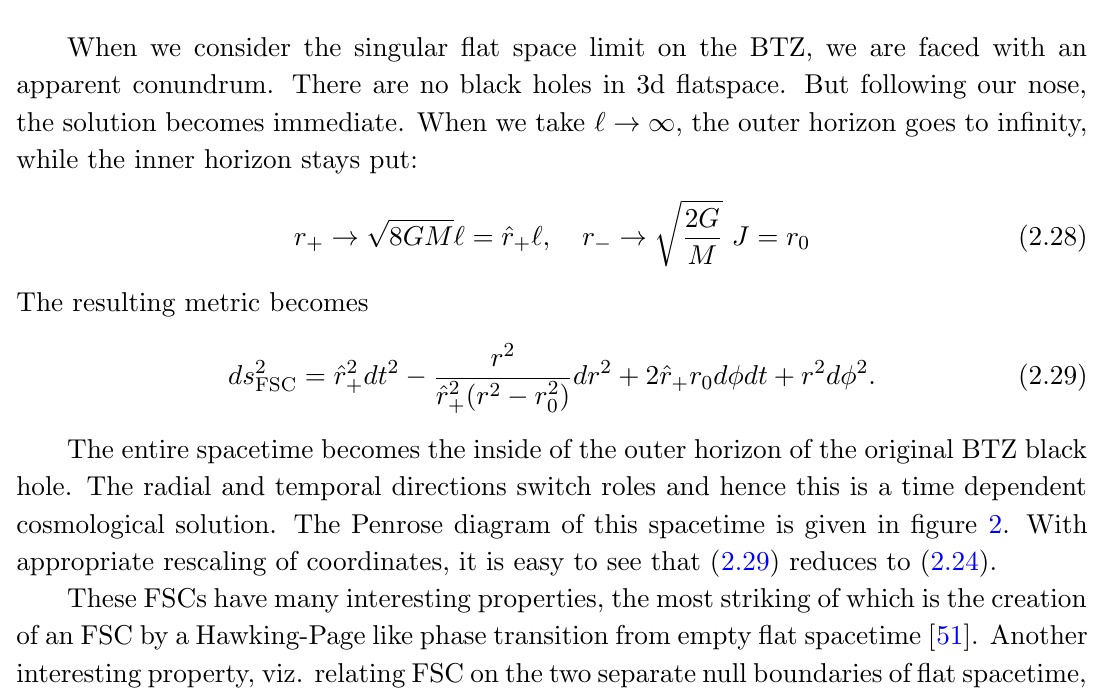
Figure 2 . Penrose diagram for Flat Space